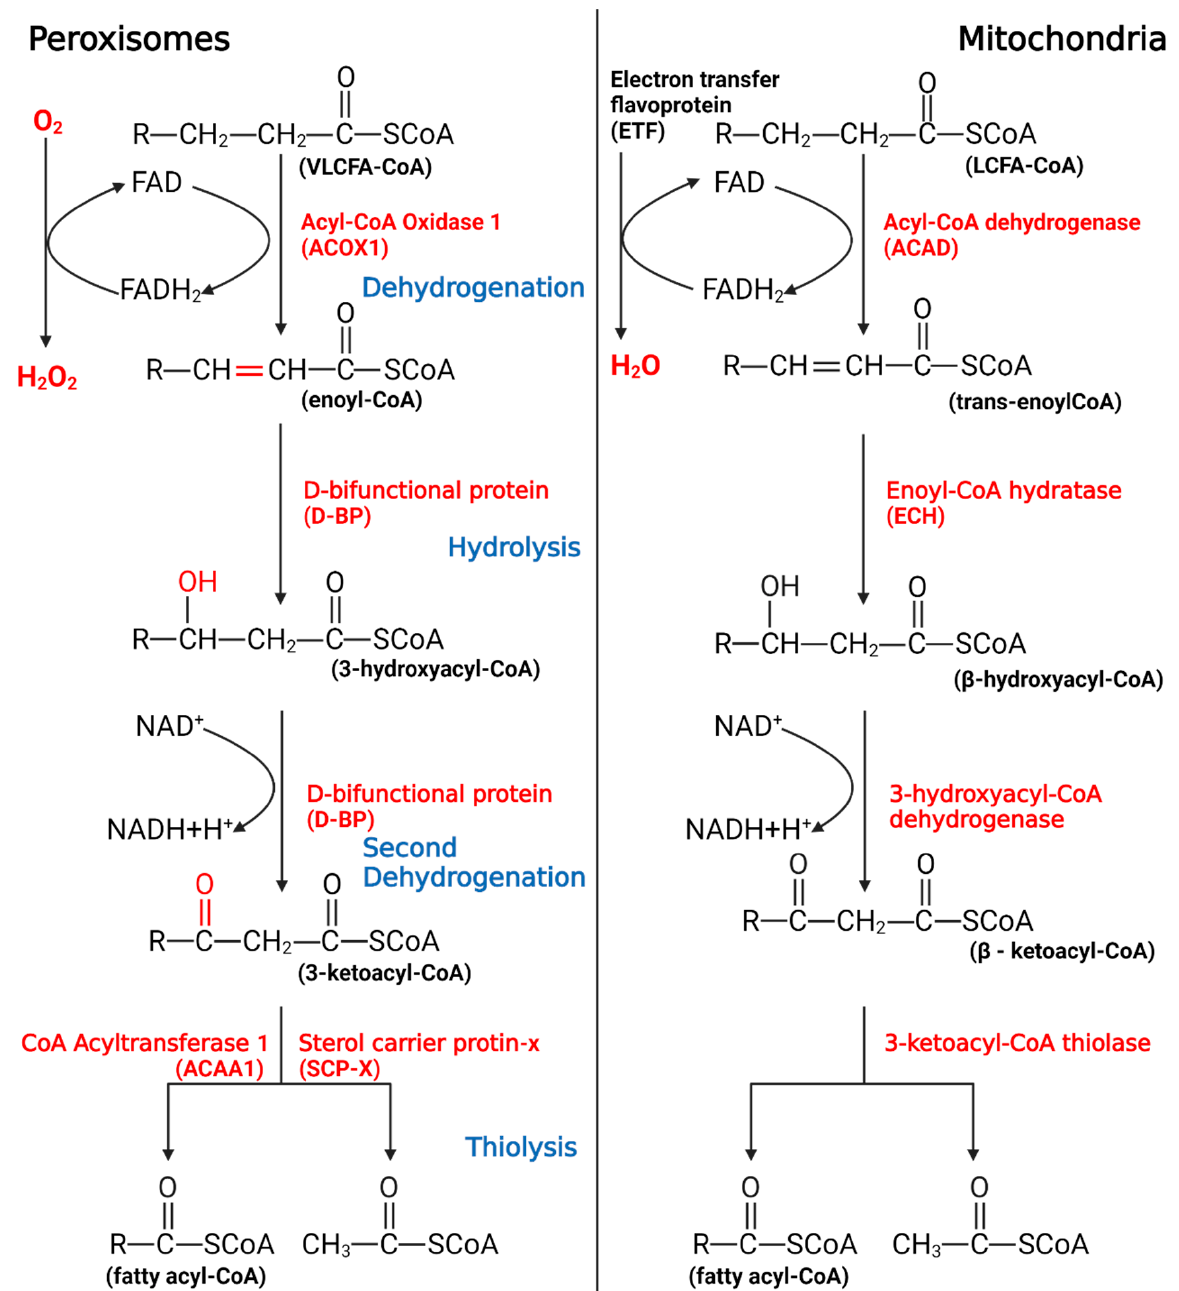
Figure 1. The process of peroxisomal β -oxidation.